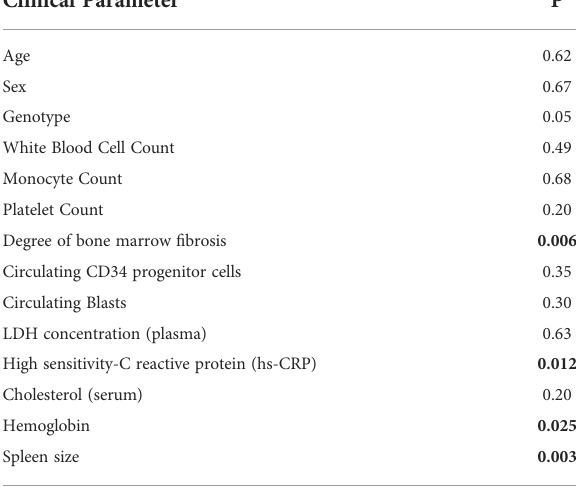
TABLE 2 Correlation of EDA-FN plasma levels with demographic, clinical and pathological characteristics of PMF patients. P = p value. Clinical